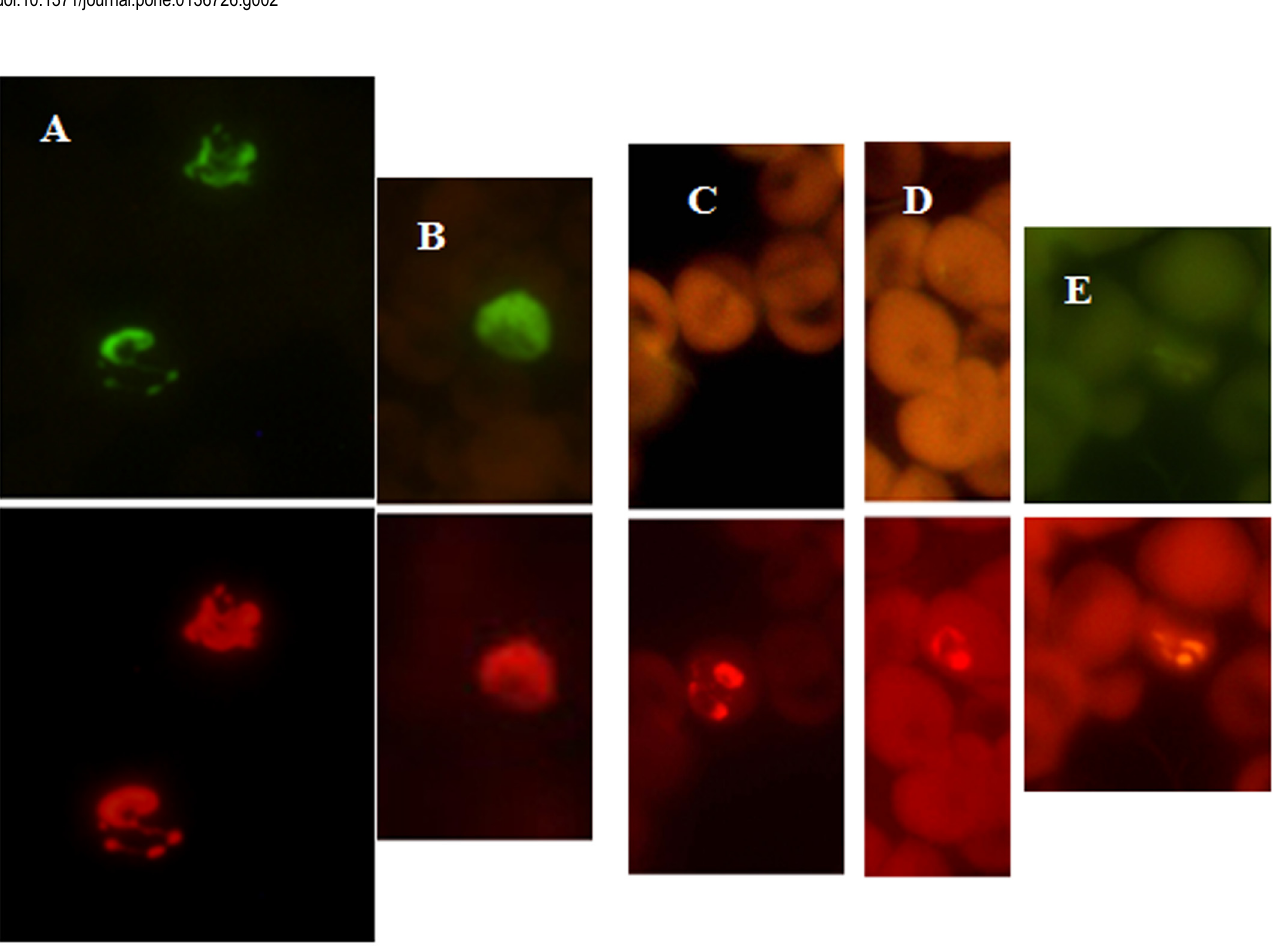
Fig 3. Blood smears tested with P . vivax FISH assay. Malaria positive patient blood samples from two collection sites, Peru (A), India (B) and Kenya (C-E) were analyzed using PV-FISH assay. (A) Patient blood positive for P . vivax . (B) Patient blood positive for P . vivax . (C) Patient blood positive for P . ovale . (D) Patient blood positive for P . malariae . (E) Patient blood positive for P . falciparum . Green fluorescence is due to reactivity with the P . vivax specific probe and red fluorescence is due to reactivity with the Plasmodium genus probe.